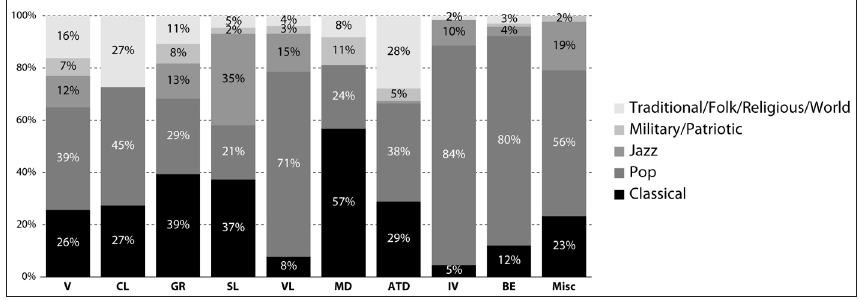
Figure 8: Distribution of genres for each